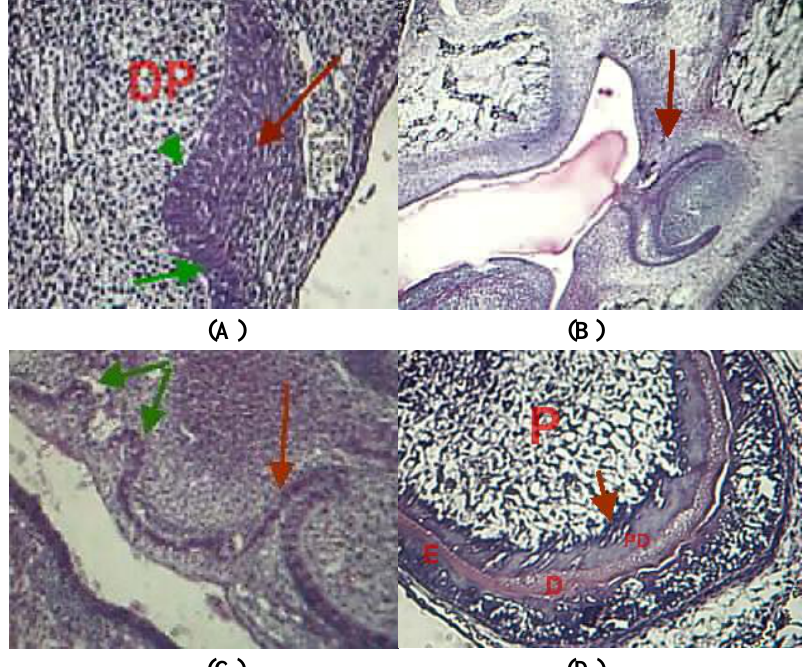
Figure 2:Experimentalgroup (H&E stain). (A) Upper jaw of rat at 16th day IUL shows. Inner enamel epithelium (green arrow head),outer enamel epithelium(green arrow), proliferating packed cells(red arrow) (X10). (B) At 18 th day I.U.L tooth germ at bell stage (arrow) (X4). (C) Multiple tooth germs (X40). (D) One day post natal, tooth germ shows, dentine (D),predentine(PD) pulp(P), enamel(E), odontoblast(OD)